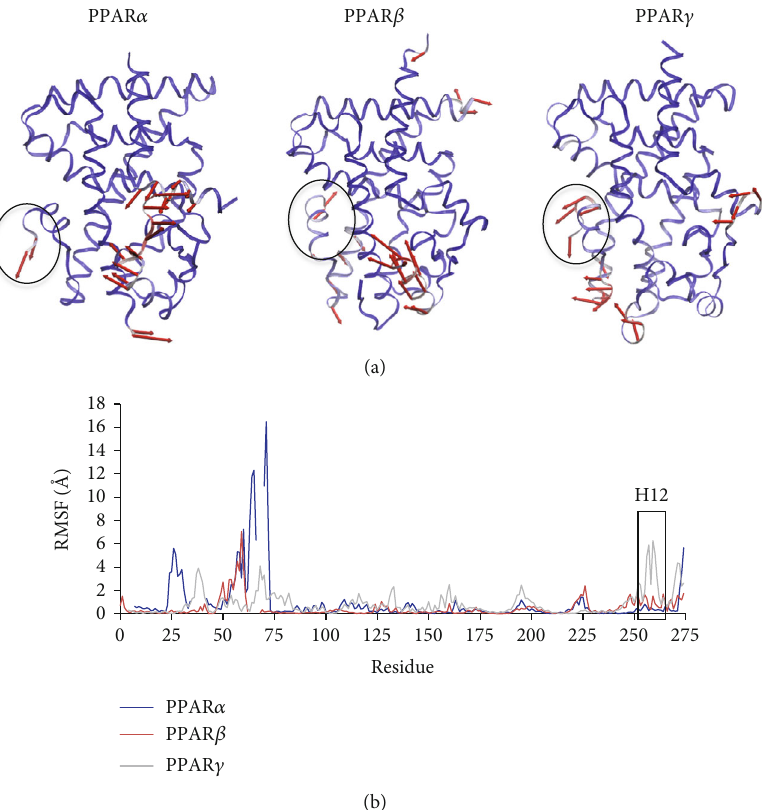
Figure 13: Snapshots of Mode 1 from the trajectory-based principal component analysis (a) and root mean square fl uctuation of Mode 1 (b). For the principal component analysis, vectors (red) that are longer than 3.5Å are